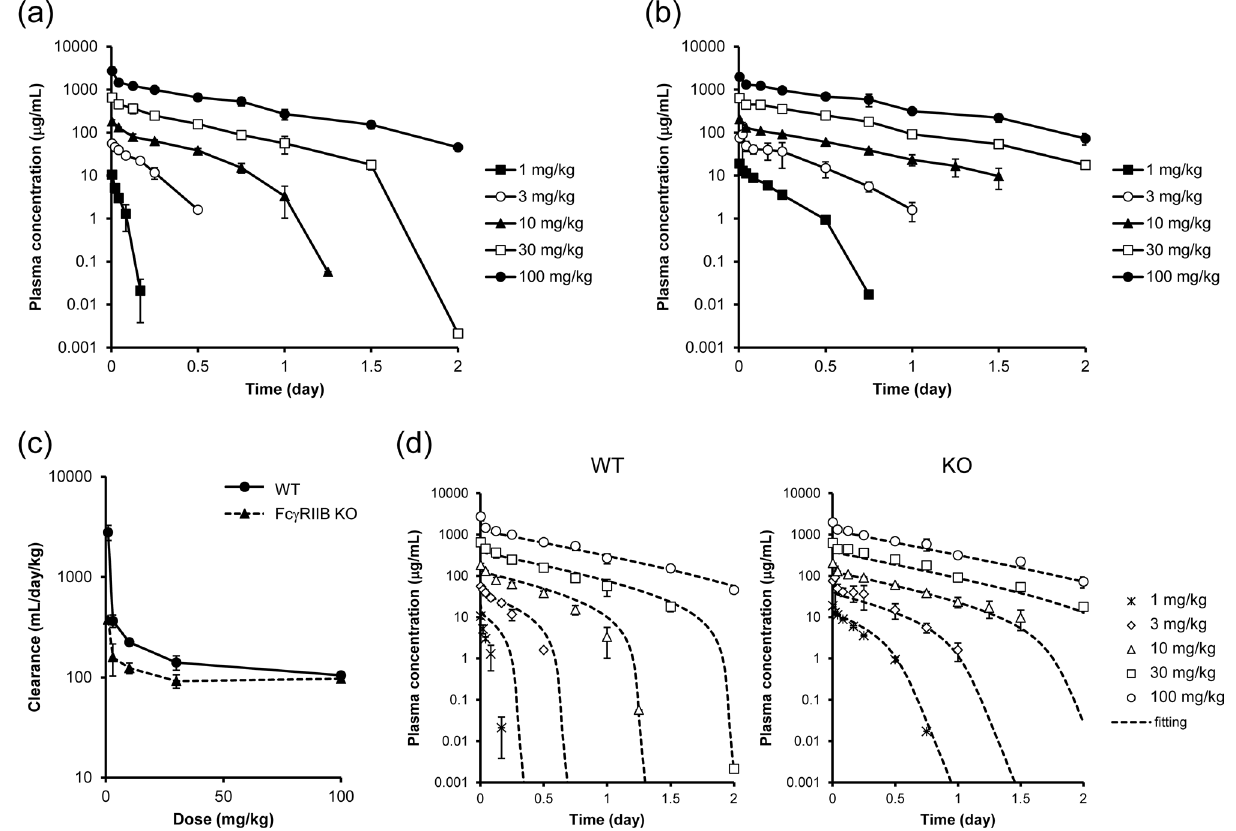
Figure 2. In vivo mouse PK profiles of anti-mouse FcγRIIB antibody. ( a ) Plasma concentration–time profile in wildtype (WT) mice. ( b ) Plasma concentration–time profile in FcγRIIB knockout (KO) mouse. The antibody was intravenously administered at doses of 1, 3, 10, 30, and 100 mg/kg, and plasma was collected time- continuously. The plasma concentrations of the antibody were quantified by ELISA. ( c ) The relationship between clearance and injected dose. ( d ) Simultaneous fitting analysis of WT and KO mice data by using 2-compartment model with Michaelis–Menten equation. Each data point represents the mean ± SD (n = 3).